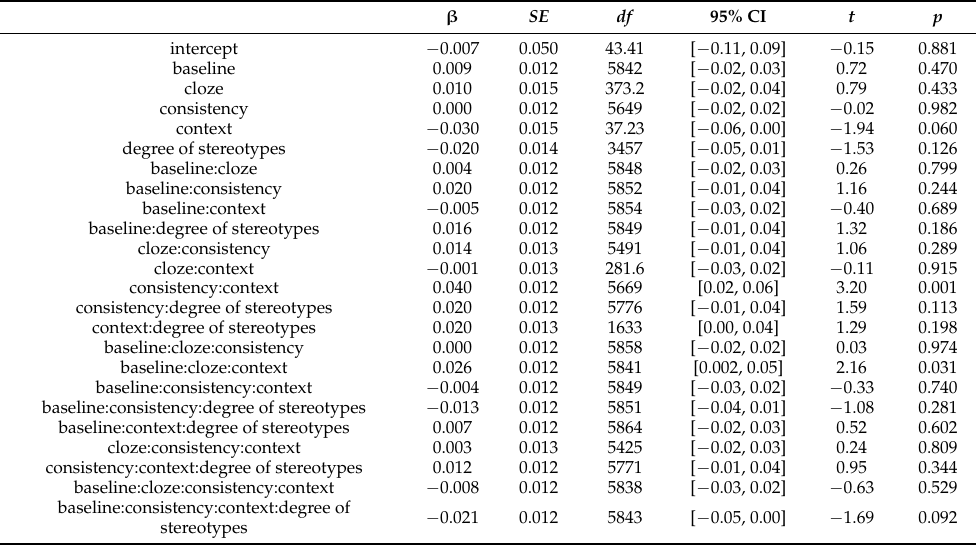
Table 2. Estimates of fixed effects in the N400 (350–600 ms) time window. β